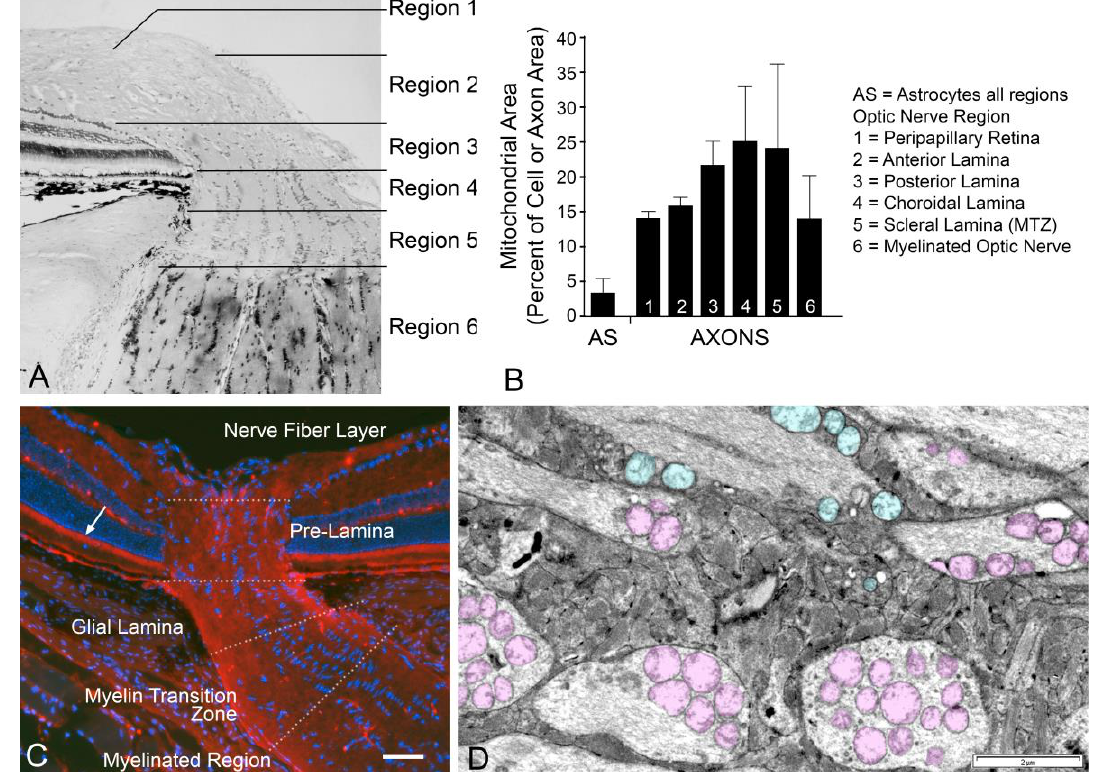
Figure 3. RGC axons in the optic nerve head contain a high concentration of mitochondria. ( A ) A histologic section through the optic nerve head of a non-human primate. Regions that were identified for a detailed ultrastructural analysis are indicated. ( B ) Graphic representation of data presented in [136] of mitochondrial area as a percentage of axoplasmic area, or cell area for astrocytes (AS), in each region of the optic nerve head. These data were originally presented in table form and are reproduced with permission from Elsevier Press. ( C ) Optic nerve section of a mouse optic nerve head, immunostained for the mitochondrial protein TOM20 (see supplemental methods). Different regions of the nerve head and adjacent regions are indicated. Note the high concentration of mitochondrial staining in the pre-laminar region, the glial lamina and the myelin transition zone (MTZ in B), as well as the photoreceptor cell inner segments (arrow). Scale bar = 100 µm (approx.). ( D ) Transmission electron micrograph of a cat optic nerve head in a region showing close apposition of unmyelinated axons and astrocytes. Mitochondria within axons are pseudo-colored pink while mitochondria in adjacent astrocytes are pseudo-colored teal. Image courtesy of Drs. Kazuya Oikawa and Gillian McLellan. Scale bar = 2 µm.